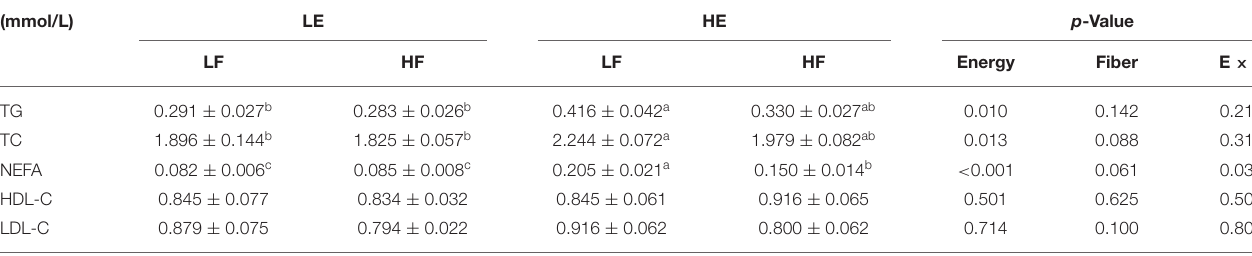
TABLE 1 | Effects of energy and fiber levels on plasma metabolites in gilts. (mmol/L) LE HE